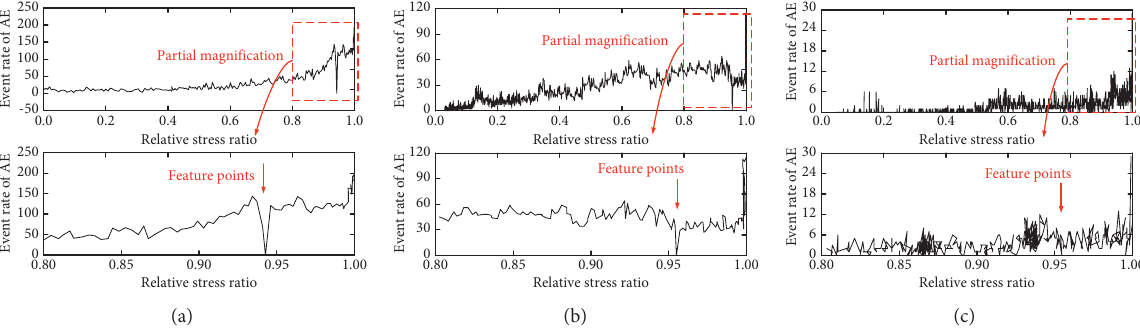
Figure 11: AE event counting rate of weakly cemented sandstone failure under different dry-wet cycles. (a) N � 0. (b) N � 5. (c) N � 10.